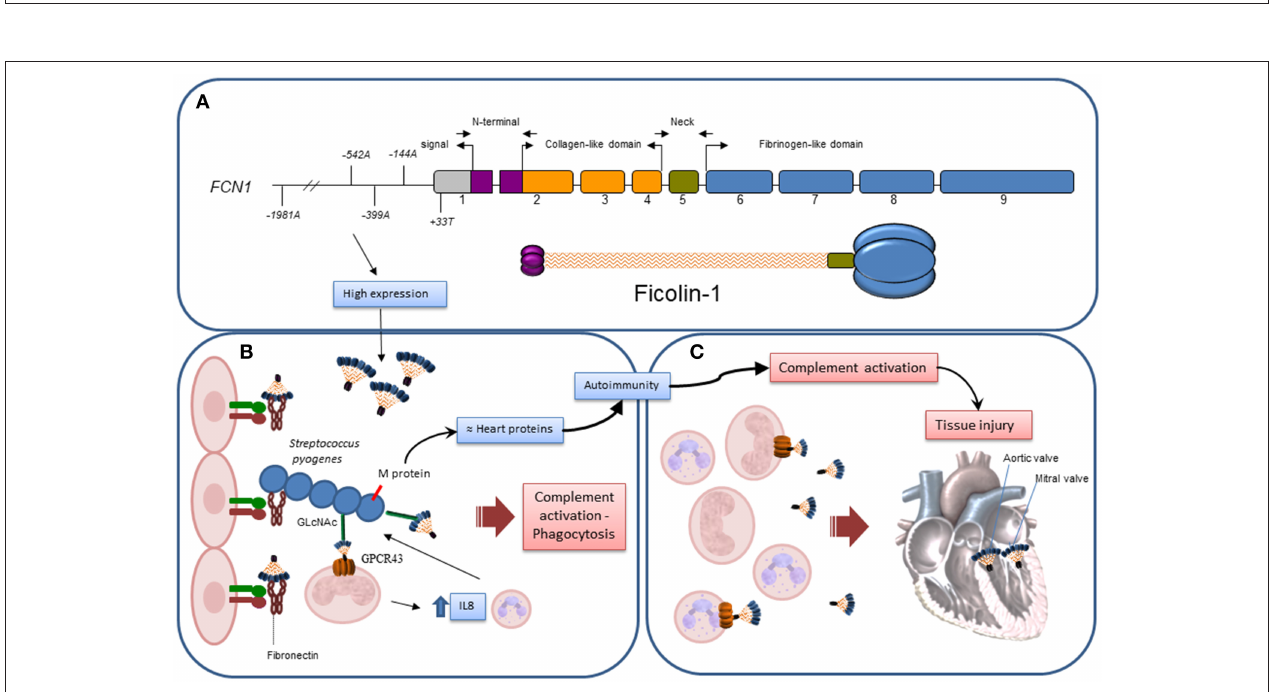
FIGURE 4 | Hypothetical actions of Ficolin-1 in RF/RHD. (A) Exon structure and correspondence to domains in the structural trimeric ficolin-1 subunit: gray – untranslated region, purple – N-terminal trimerization domain, orange – collagenous stalk, green – neck region, blue – fibrinogen C-domain. Approximate location of the investigated polymorphisms is given according to number of base pairs, counting from the first transcribed nucleotide. (B) Higher ficolin-1 levels, associated with certain FCN1 alleles in the promoter region, improved resistance against GAS infection, slowing down the process by which autoantibodies are produced due to exposure of neoepitopes in damaged tissue and structural homology of GAS’s M protein with myosin/tropomyosin. This may occur through competition for fibronectin binding in the extracellular matrix; recognition of GlcNAc in GAS carbohydrate A by phagocyte membrane-bound ficolin-1 and consequent bacteria internalization; complement activation, despite GAS’s abilities to cleave C5a, as well as C2-C9; ficolin-1/GPCR43 activation on monocytes, transducing signals through NFkB and activating interleukin-8 (IL8) gene expression, leading to chemoattraction of more phagocytes to the infection site. (C) After established infection, structures on damaged/altered cells recognized by membrane-bound or soluble ficolin-1 mediate complement activation and increases tissue injury, which may become irreversible in the cardiac valves.